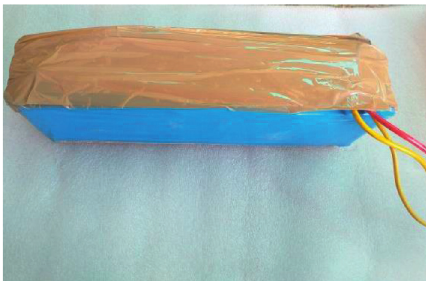
Figure 4: Model of the lithium ion battery.